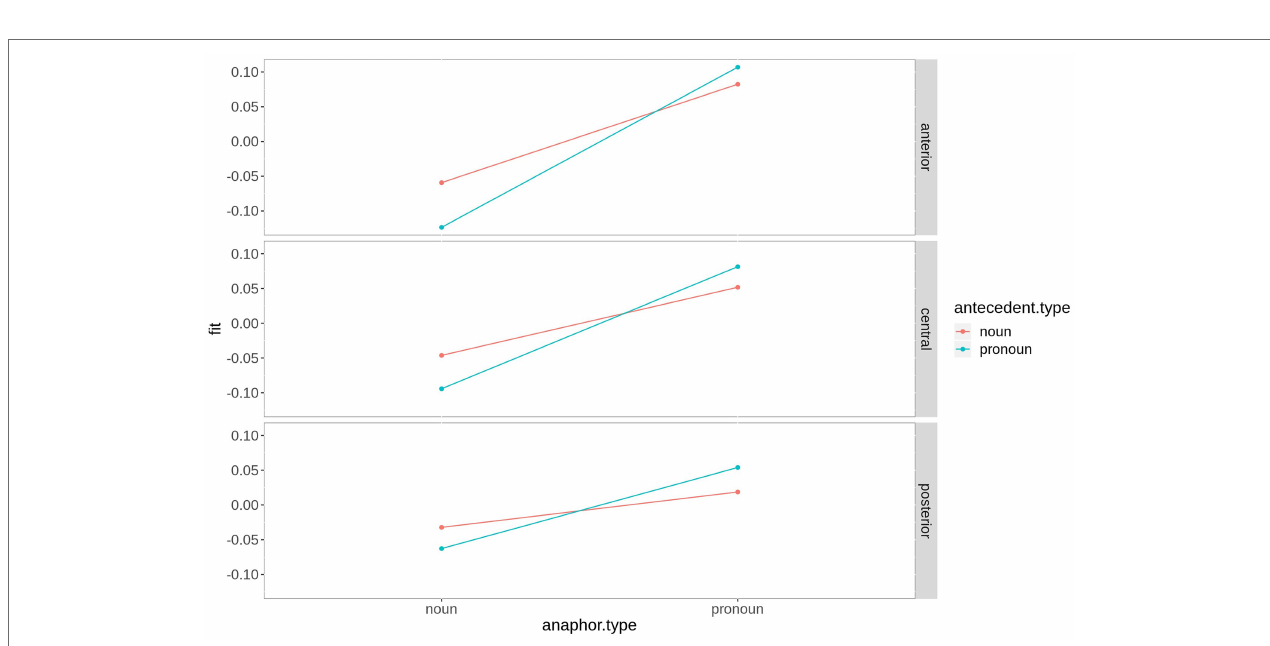
FIGURE 4 | Fitted values for the interaction laterality*anaphor type in the P300 time window. For plotting purposes, the continuous variable laterality was grouped into ROIs based on 2-dimensional coordinates.